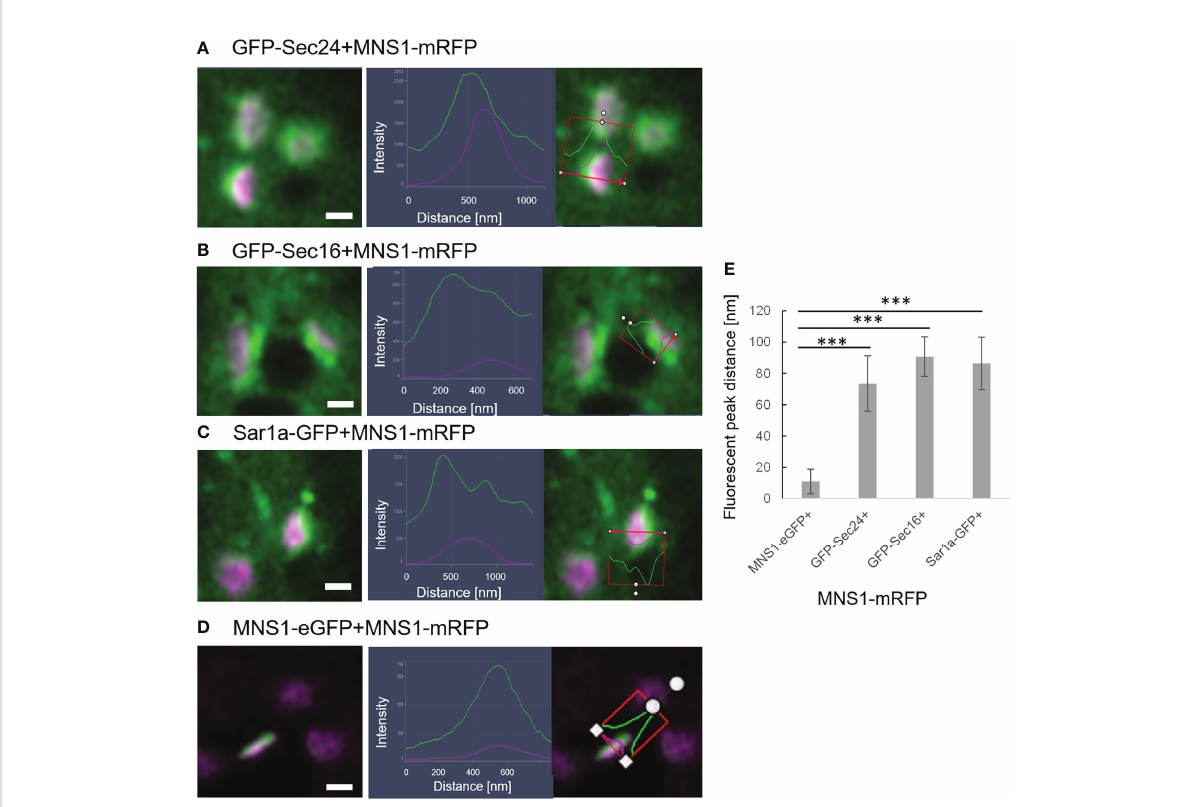
FIGURE 8 ERES markers de fi ne a pre-Golgi compartment. ERES markers GFP-Sec24 (A) , GFP-Sec16 (B) and Sar1a-GFP (C) are distributed closely to the cis -Golgi-marker MNS1-mRFP but do not fully overlap with MNS1-mRFP. Merged images in a side view are shown together with line pro fi les for both markers. Proteins were expressed transiently in tobacco leaf epidermal cells. Size bars = 0.5 µm. (D) MNS1-eGFP and MNS1-mRFP were coexpressed as a control for full colocalization. (E) Statistical analysis shows the distance [nm] between fl uorescent peak of ERES marker and MNS1-mRFP. Signi fi cance was analyzed by Kruskal-Wallis (***p< 0.001). n = 3 with 5 technical replicas